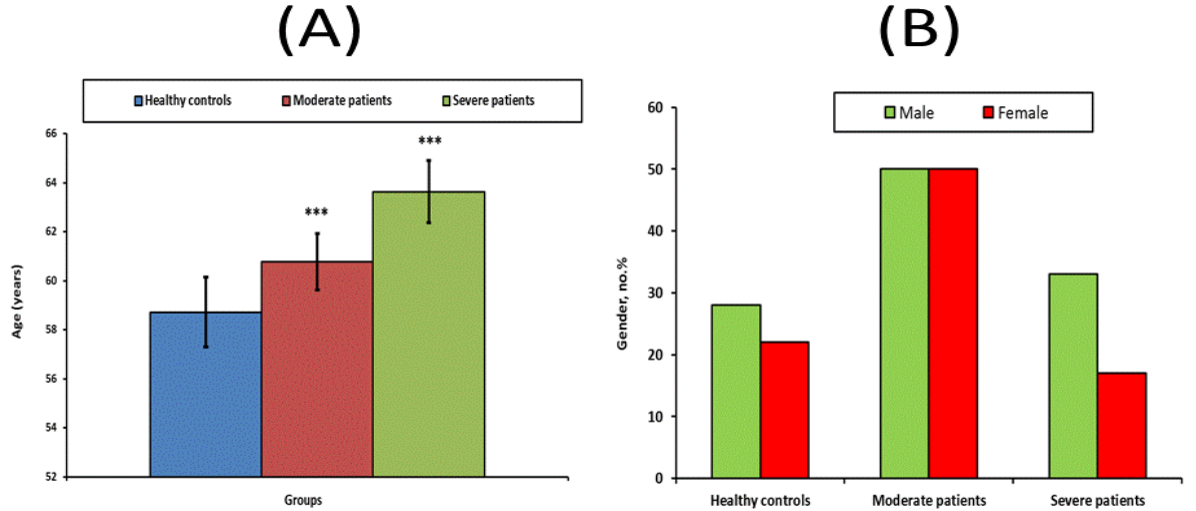
Figure 1. Age ( A ) and gender ( B ) of healthy controls, and moderate and severe groups. *** Significant at p < 0.001.